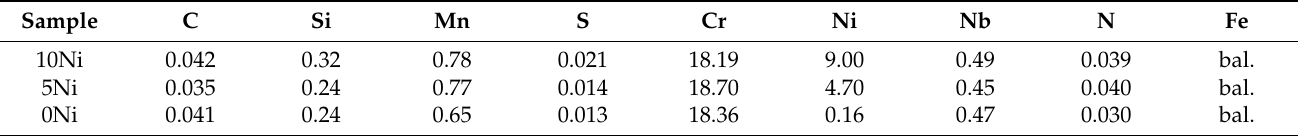
Table 1. Chemical compositions of as-cast samples expressed in percent by weight.